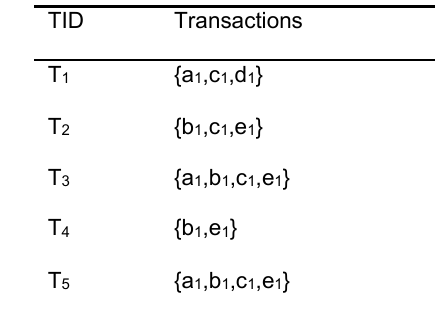
Table 1. Transactions’ sample in a